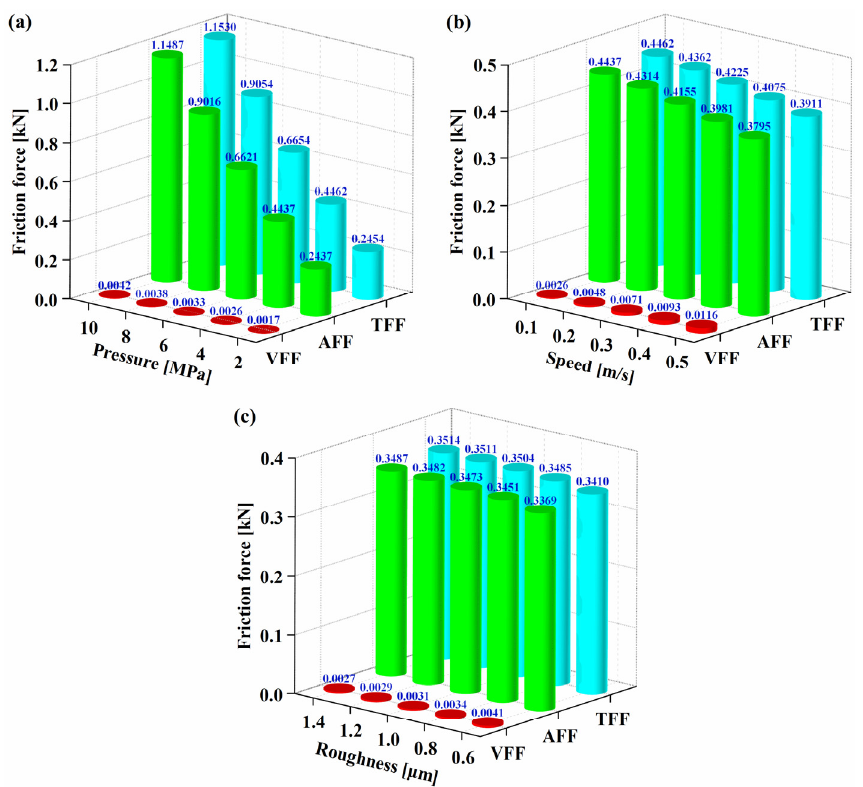
Figure 12. Variation of total friction force (TFF), asperity friction force (AFF) and viscous friction force (VFF) with ( a ) sealed pressure, ( b ) rod speed, and ( c ) surface roughness.